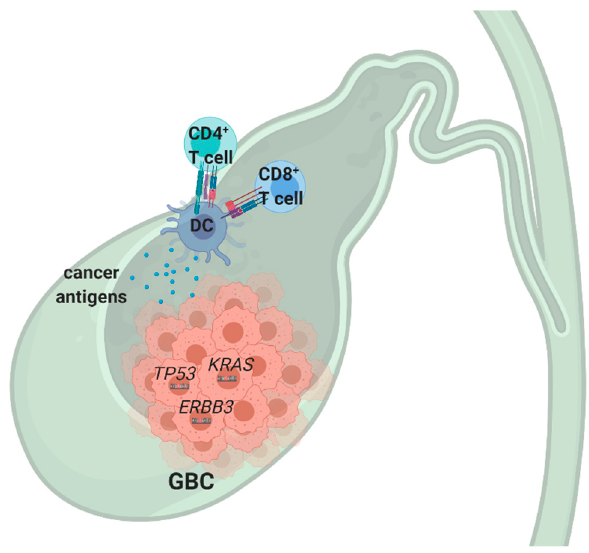
Figure 4. Molecular characterization of recurrent mutations and immune infiltrates in GBC. Abbreviation: DC: Dendritic cell.